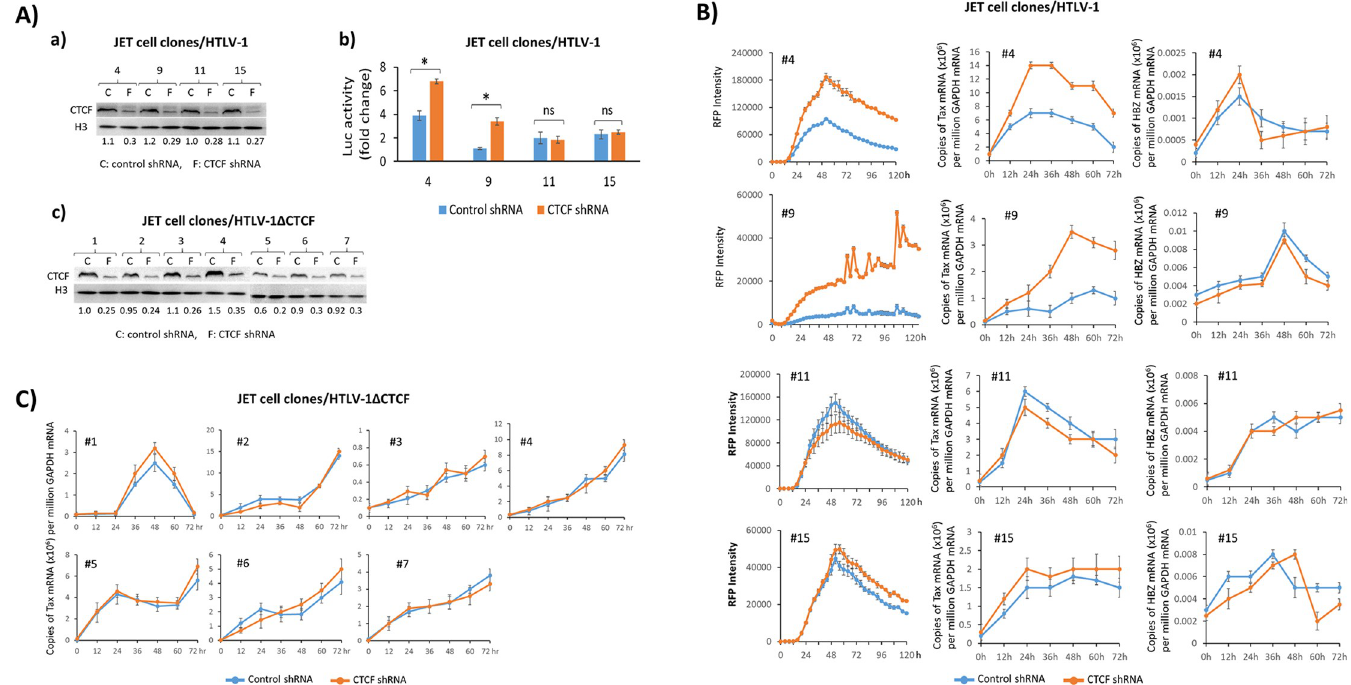
Fig 5. Inhibition of CTCF binding to HTLV-1 provirus affects proviral gene transcription. Clonal HTLV-1 (A-a and B) or HTLV-1 Δ CTCF (A-c and C) infected JET cell lines were generated, each carrying a single, latent provirus at a unique integration site. The infected JET cells from panels B, and C were collected and cellular CTCF was detected by Western blotting using anti-CTCF antibody. Histone H3 was also blotted as a loading control. The amount of CTCF was measured by densitometry quantification using BioRad image lab software, normalized to the value of histone H3 and is indicated under each lane. A-b). The JET cells from Fig 5B were cocultured with Jurkat cells expressing firefly luciferase driven by the HTLV-1 LTR (LTR-Luc) in the presence or absence of PMA/Ionomycin for 48 hr and viral infectivity was determined by measuring luciferase activity and presented as a fold change compared with the values of untreated cells (t test: � p < 0.05; ns: not significant). B & C). Viral gene expression was activated with PMA/Ionomycin and monitored by measuring Tax mediated RFP production using the IncuCyte live cell image system. The levels of tax and hbz mRNA were also measured by qRT-PCR. Total copy number of each mRNA was determined using plasmid DNA standards and normalized to 10 6 copies of GAPDH mRNA. Cell clone number of HTLV-1 infected and HTLV-1 Δ CTCF cells are indicated in each panel. Each experiment was repeated three times and a representative result with three replicates is shown with standard errors.